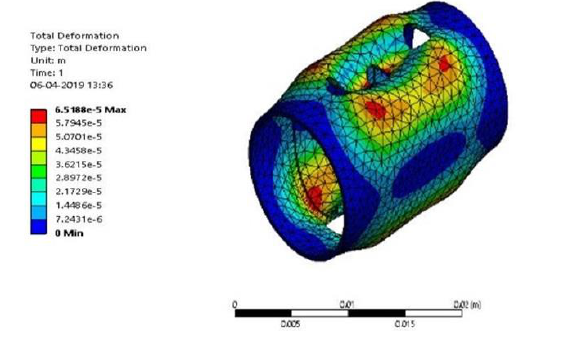
Fig. 13. Deformed babbitt 2 under pressure from oil film